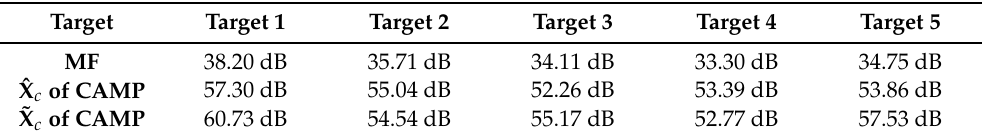
Figure 1. Images restored by different methods: ( a ) MF-based; ( b ) ˆX C of CAMP; ( c ) ˜X C of CAMP; ( d ) Amplitude deviation between ( c ) and ( a ). Table 1. TBR of images reconstructed by MF and CAMP-based